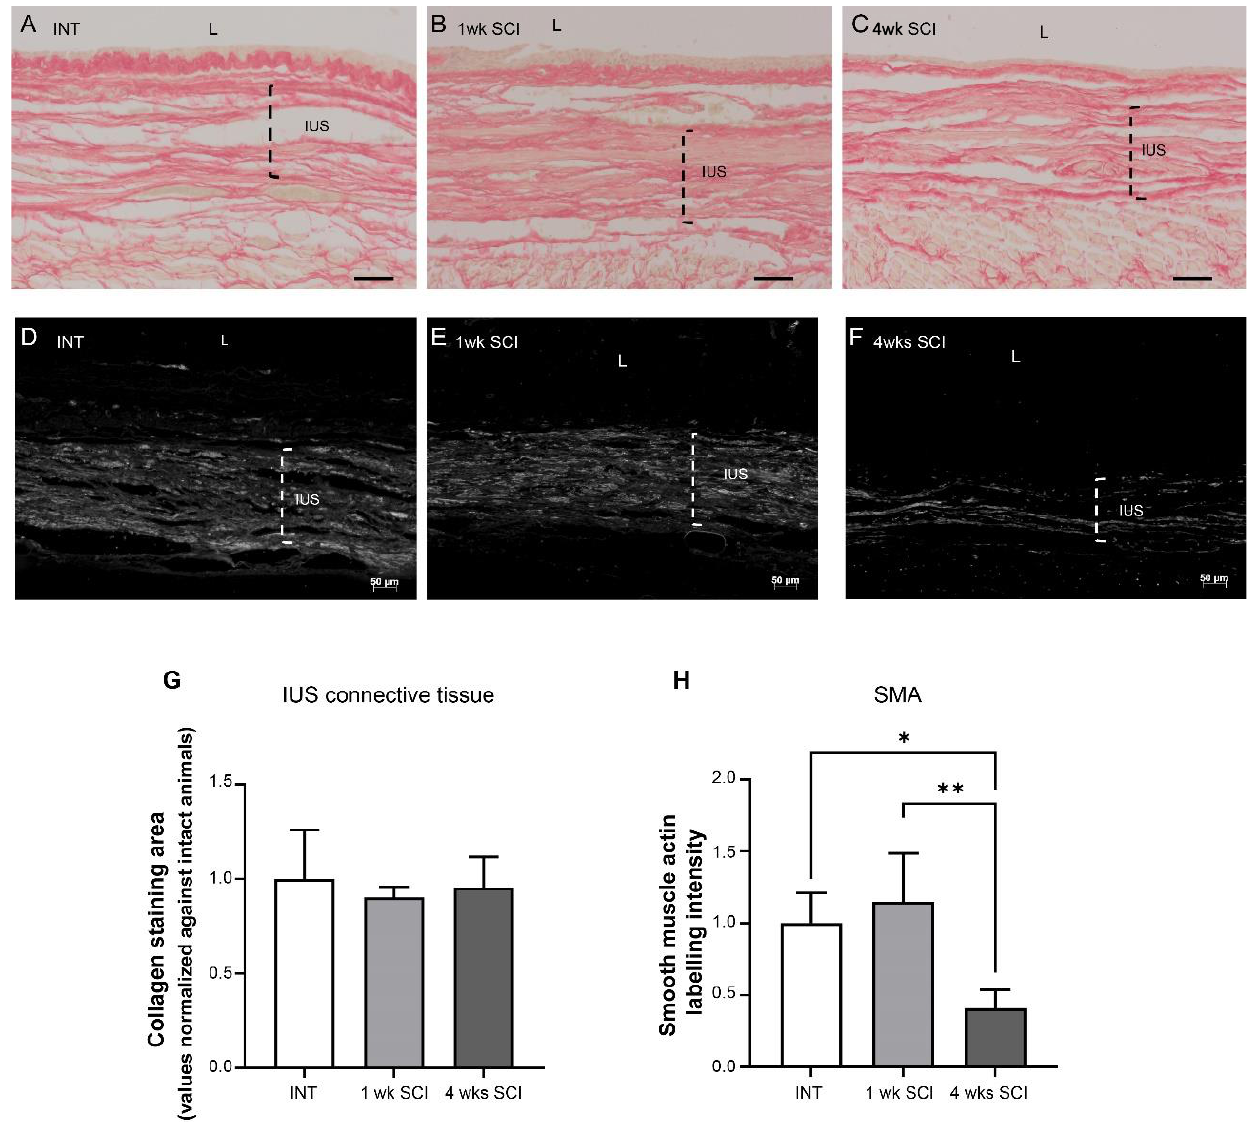
Figure 3. Internal urethral sphincter integrity. The integrity of the internal urethral sphincter (IUS) was measured by Sirius Red staining. Intact ( A ), 1 wk SCI ( B ) and 4 wks SCI ( C ) animals presented no changes in connective tissue arrangement ( G ). Immunostaining of smooth-muscle actin (SMA) showed that spinal intact ( D ) and 1-week SCI animals ( E ) presented a tick IUS with strong actin expression. In sections from animals left to recover 4 weeks after spinal lesion ( F ), there was evi- dence of a marked decrease in SMA expression. The quantification of the IUS labelling intensity of actin in the proximal urethra ( H ) (n = 4). One-way ANOVA followed by a Tukey ’ s multiple com- parison test (* p < 0.05 versus INT; ** p < 0.01 versus 1-week SCI). 2.3.2. External Urethral Sphincter The effects of SCI on the arrangement of the external urethral sphincter were also analysed. In INT sections stained with haematoxylin – eosin, it was possible to observe long striated muscle fibers (Figure 4A). The average transverse area of striated fibres was 10.48 ± 4 .8 μm 2 (Figure 4G). Observations were also made in sections from 1-week and 4- weeks post-SCI animals (Figure 4B,C), and the average transverse areas, respectively , were 8.52 ± 1.00 and 6.43 ± 0 .73 μm 2 (Figure 4G), suggesting a trend towards slimmer muscle fibres that did not reach statistical significance. Sirius red staining showed signif- icant signs of fibrosis in SCI animals, with a thick bundle of connective fibres between striated muscle cells evident at 1 and 4 weeks post-SCI (Figure 4D – F,H; * p < 0.05 and ** p < 0.01 versus INT).